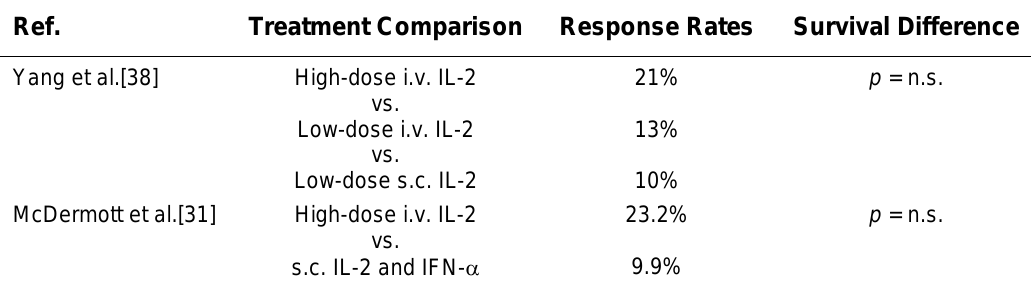
Randomized Trials of i.v. vs. s.c. IL-2 in Advanced RCC Patients